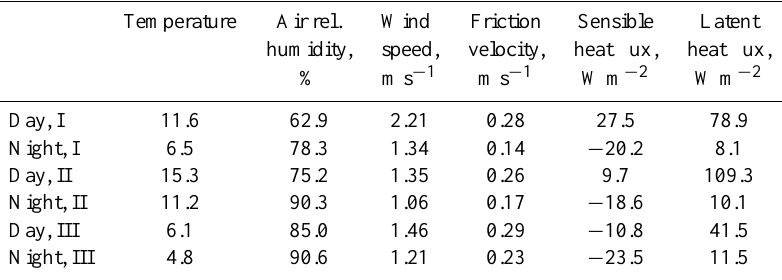
Table 5. Average micrometeorological conditions during the experimental periods. Period I DOY 110–181 (20 April–30 June 2011), period II DOY 206–271 (25 July–28 September 2011), period III DOY 272–324 (29 September–20 November 2011). Daytime was defined by the elevation of sun higher than zero and night-time lower than zero, respectively. Average latent heat fluxes were determined from IRGA measurements. Temperature Air rel. Wind Friction Sensible Latent humidity, speed, velocity, heat